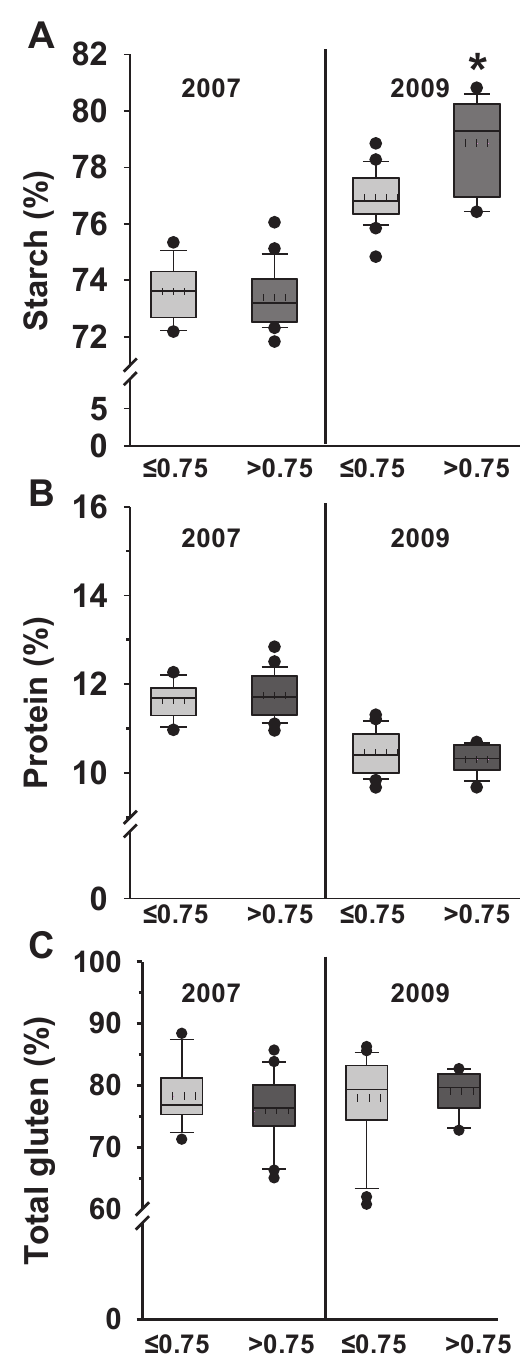
Fig. 3: Starch (A), protein (B), and total gluten (C) content of flour Type 550 samples in 2007 and 2009 grouped into fulfilling (≤0.75) and exceeding (>0.75) EU maximum level of DON (mg kg -1 ) for flour. Significant difference between groups within year is indicated through * (p<0.001). Box plots show 25-75% percentile, median (solid line), and mean (dotted